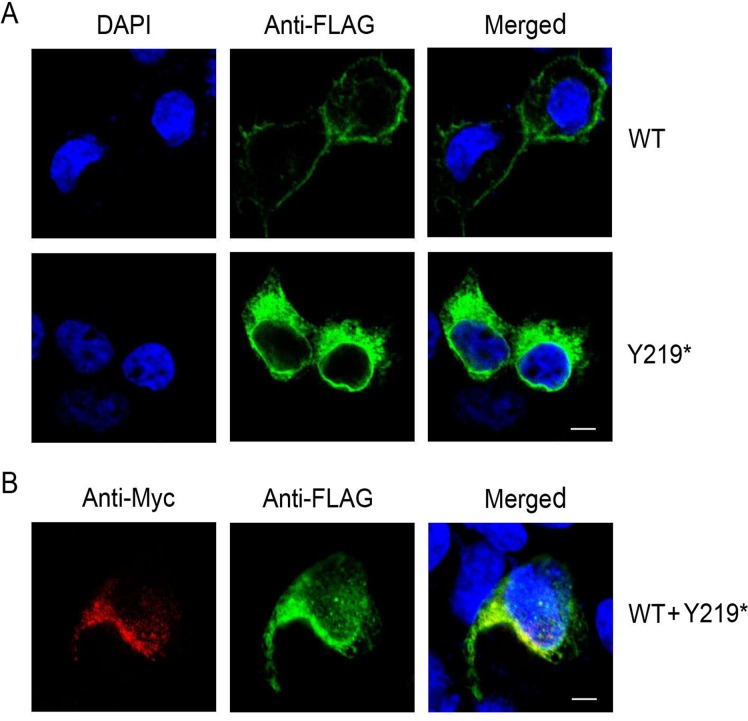
Subcellular localization of WT-AQP0 and Y219*-AQP0in HEK 293T cells, 24 h after transient transfection.Bar 5μm. A: Localization of singly transfected FLAG-tagged wild-type (WT) and mutated (219*) AQP0 proteins. Photomicrographs show the distribution of immunoreactive FLAG-tagged AQP0 (green) and DAPI-stained nuclei (blue) B: Localization of co-transfected FLAG-WT-AQP0 and Myc-219*-AQP0 proteins. Photomicrographs show the distribution of immunoreactiveMyc-tagged 219*-AQP0 (red), FLAG-tagged WT-AQP0 (green) and DAPI-stained nuclei (blue)